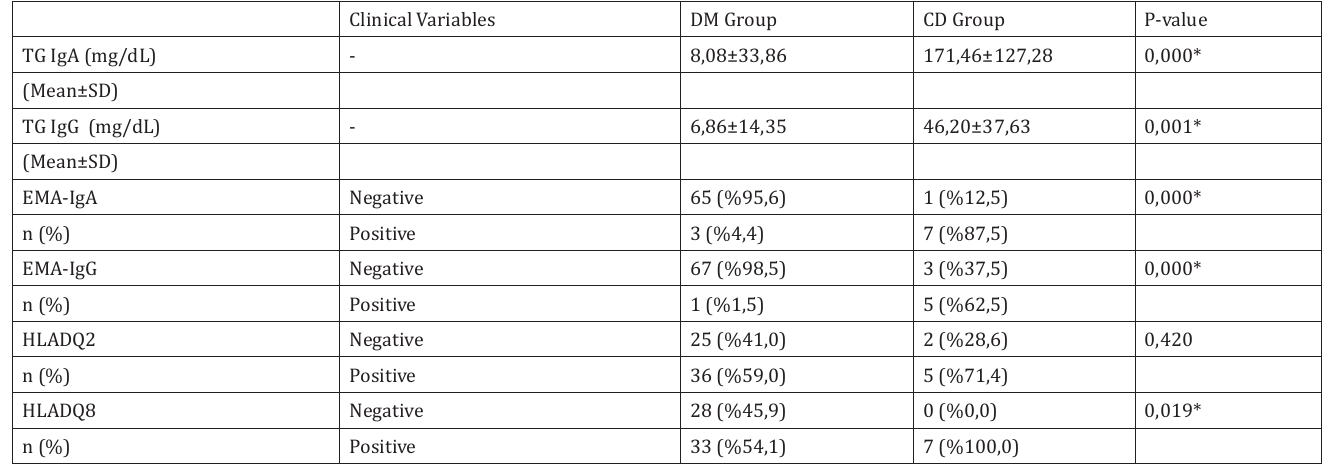
Results of serological screening in DM and CD patients.